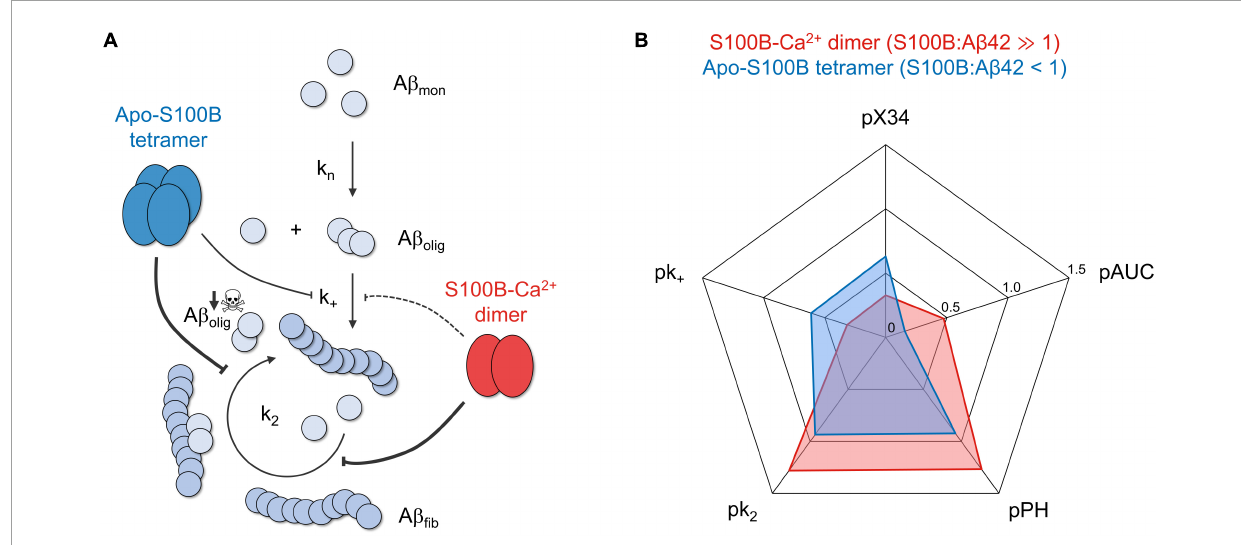
FIGURE5 The chaperone activity of dimeric and tetrameric S100B suppresses the generation of intermediate oligomers during A β 42 aggregation. (A) S100B dimer and tetramer suppression of A β 42 oligomerization based on the discreetly distinct inhibition of multiple aggregation micro-steps and the preferential targeting of fibril catalyzed secondary nucleation. (B) Radar plot illustrating the complementary effect of dimeric (red) and tetrameric (blue) S100B, under the conditions tested, on the diverse parameters illustrating A β 42 aggregation and oligomer formation: secondary nucleation and fibril elongation rate constants ( k 2 and k + , respectively), maximum oligomer influx and total number of oligomers (measured, respectively, by peak height, PH, and area under the curve, AUC, of A β 42 oligomerization distributions) and relative amounts of X-34 positive oligomers. To facilitate data comparison, each parameter was transformed by applying the operator p (–log 10 ), such that a higher inhibition will result in a more eccentric point in the